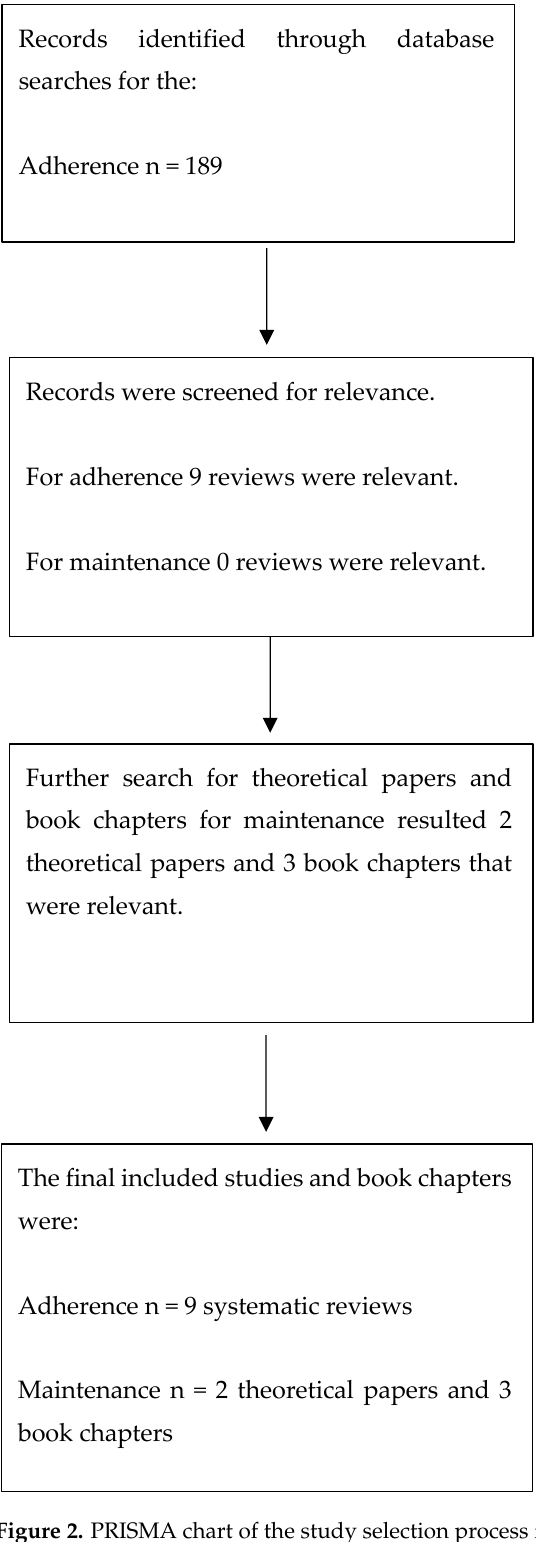
Figure 2. PRISMA chart of the study selection process for the second